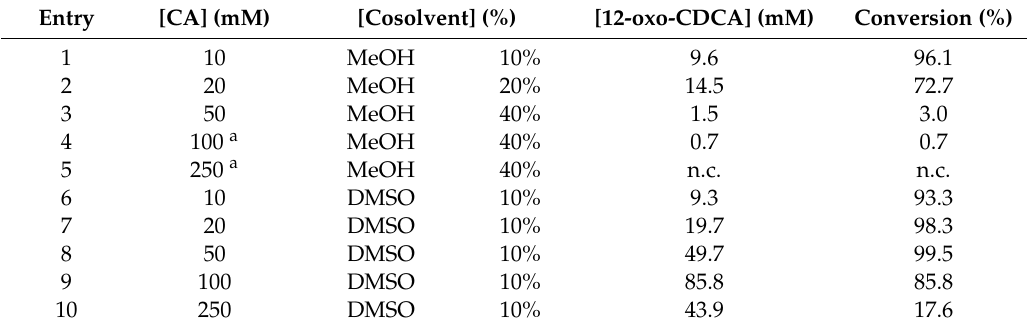
Table 1. Analytical scale bioconversions of CA to 12-oxo-CDCA when the El 12 α -HSDH / Mt Lac / syringaldazine system is employed with di ff erent substrate loadings (10, 20, 50, 100 and 250 mM) and di ff erent cosolvents at pH 7.2. All reactions were carried out for 48 h at 25 ◦ C. Conversions were determined by HPLC analysis. All bioconversions were carried out employing 0.34 mg / mL (1.8 U /